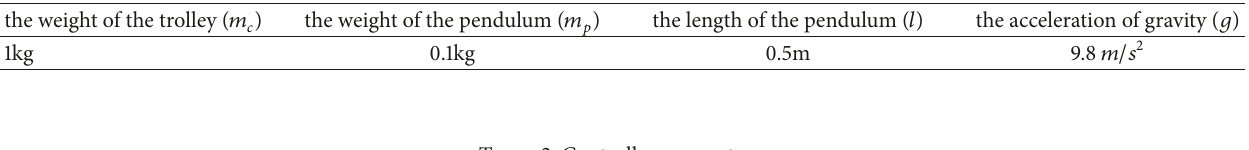
Table 1: System model parameters.